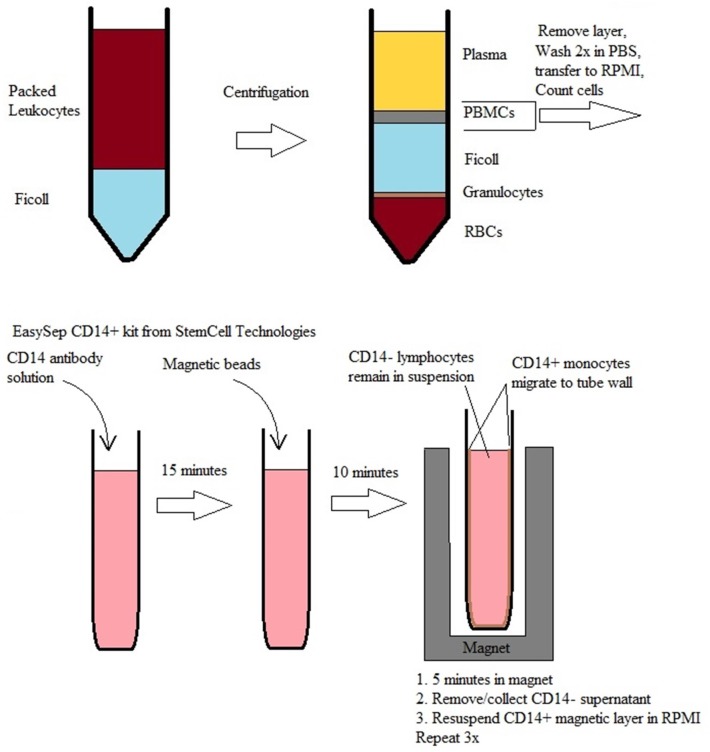
Workflow for isolation and purification of lymphocytes and monocytes from donated packed leukocytes.Packed Leukocytes are carefully pipetted over a layer of Ficoll in 50 ml falcon tubes, and centrifuged at 1600 rpm/530 G for 30 min with no brake. PBMC layer is extracted with a pipette and washed 2 times in PBS and the final pellet is re-suspended in RPMI to a concentration of 108 cells/mL. EasySep CD14 antibody solution is added at 100 μL/10^8 cells. Incubation at room temperature for 15 min followed by EasySep magnetic beads at 50 μL/108 cells. After 10 min incubation to allow antibody binding to beads, the tube is placed in the magnet for 5 min. CD14+ cells (monocytes) migrate to the walls of the tube leaving only CD14- cells (lymphocytes) in suspension. While the tube remains in the magnet, the supernatant is poured off and collected. The tube is removed from the magnet, RPMI added, pipetting up and down to resuspend CD14+ cells, and the tube is returned to the magnet. The process is repeated 3 times.